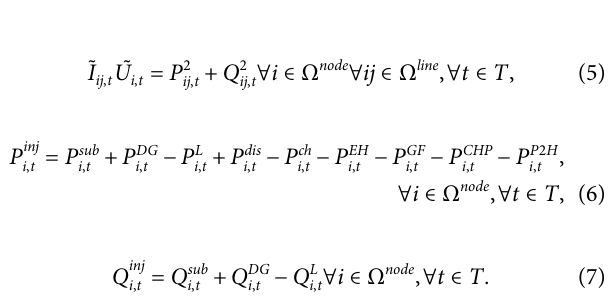
FIGURE 1 | Schematic diagram of multi-energy